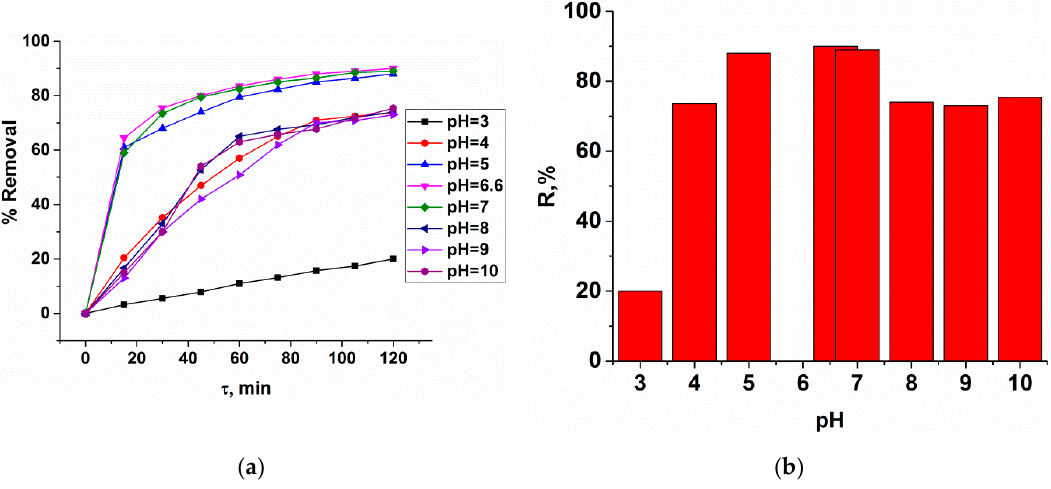
Figure 7. Dependence of the degree of MB adsorption on pH ( a ) and the maximum degree of MB adsorption on copper trimesinate depending on pH (t = 120 min) ( b ).